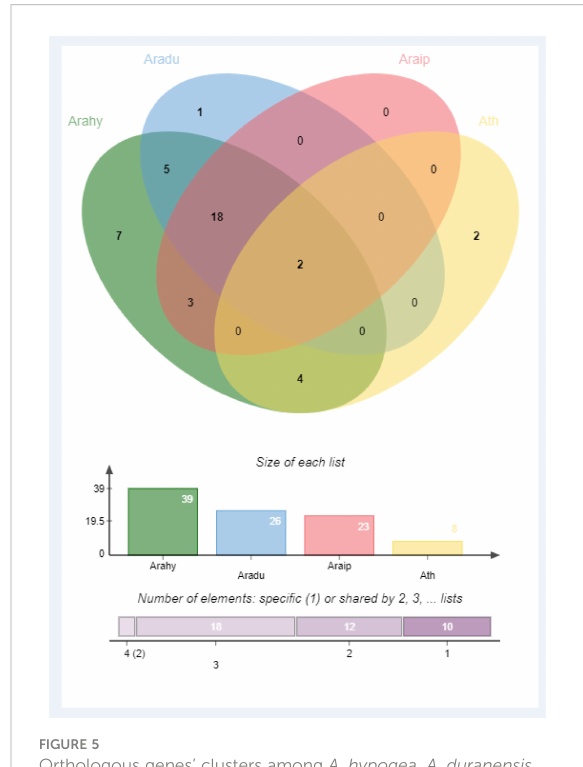
FIGURE 5 Orthologous genes ’ clusters among A. hypogea , A. duranensis , A. ipaensis , and A. thaliana . A. hypogea recorded maximum clustered. Eighteen gene clusters are solely composed of GLPs found in peanut diploid and tetraploid species, indicating that polyploidization has evolved new peanut-speci fi c orthologous GLP gene